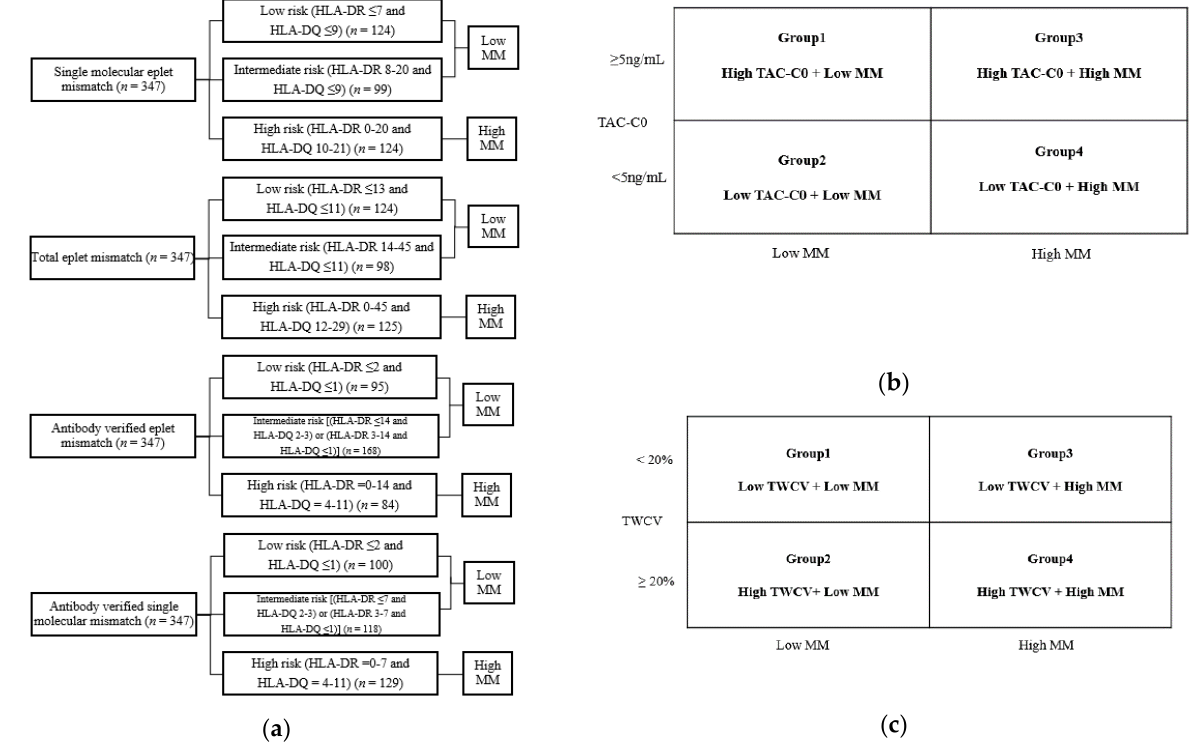
Figure 2. Distribution of patients according to eplet mismatch, TAC-C0 and TAC-IPV. ( a ) Patient distribution according to each eplet mismatch analysis, ( b ) patient groups according to eplet mismatch and TAC-C0, ( c ) patient groups according to eplet mismatch and TAC-IPV. TAC-T0, time-weighted tacrolimus trough level; TAC-IPV, tacrolimus intrapatient variability; TWCV, TAC-C0 time-weighted coefficient variability.